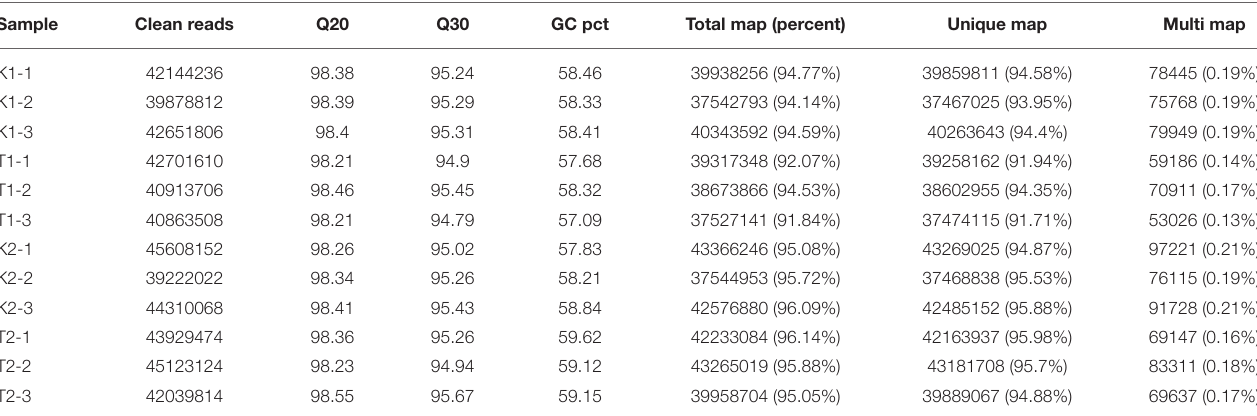
TABLE 3 | The sequencing information of samples and statistics of comparison between sample and reference